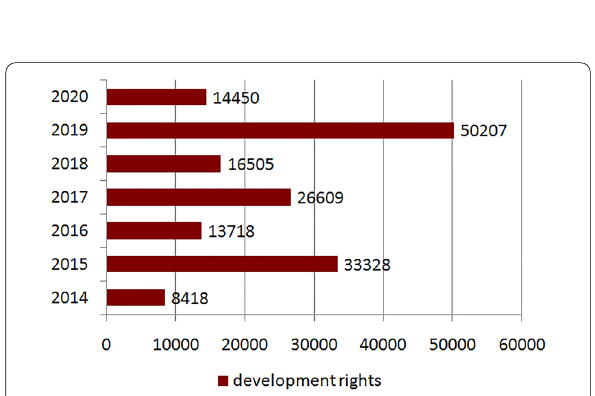
Fig. 2 Development rights recorded per year of first registration in sq.m. of gross floor